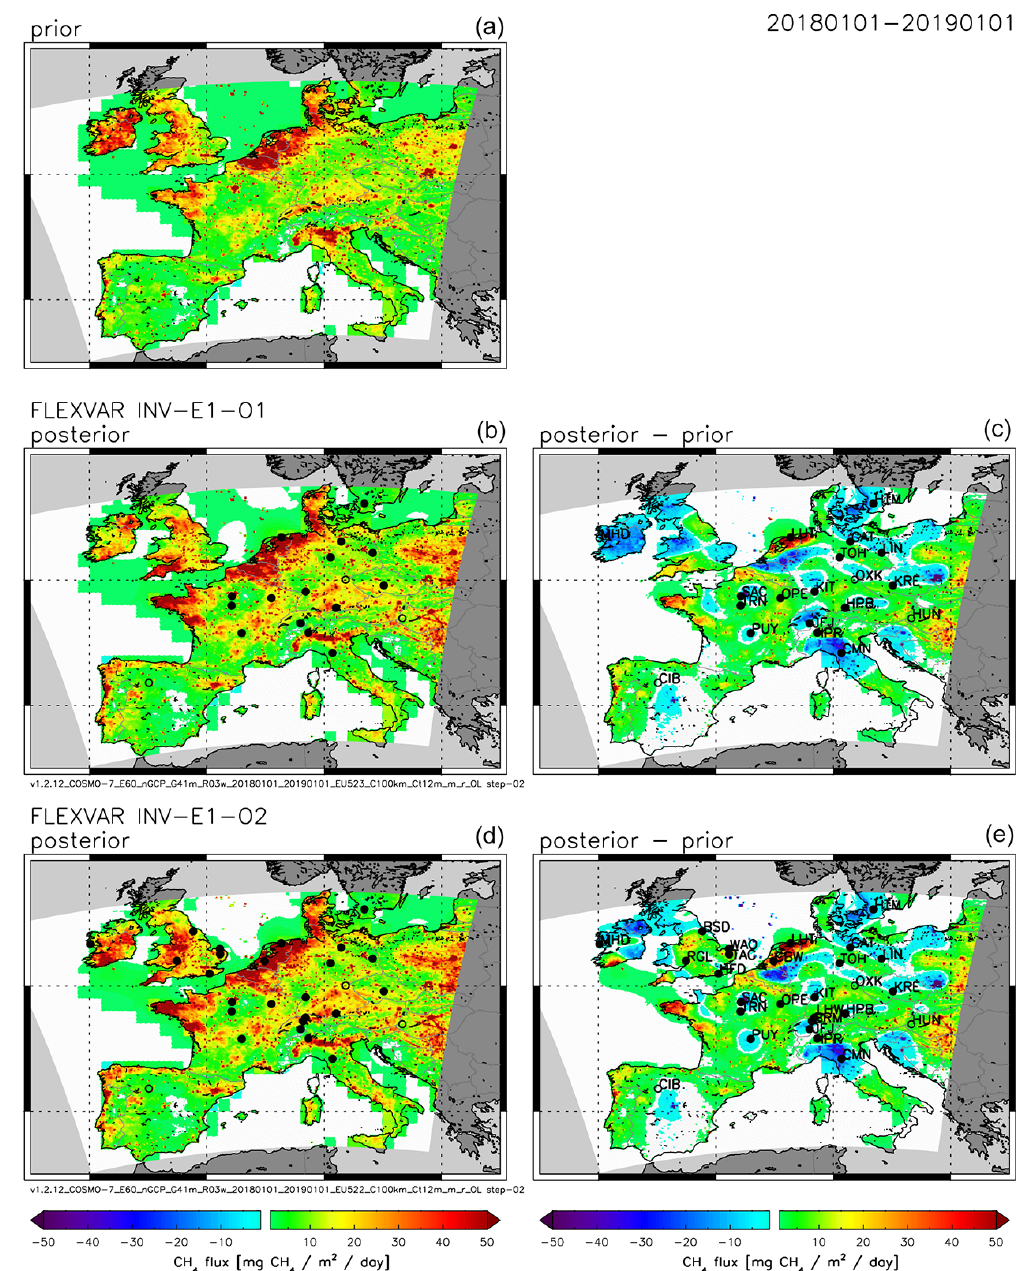
Figure 5. Sensitivity of FLEXVAR inversions to assimilated observations. (a) Prior emission. (b, c) Posterior emissions (left) and difference between posterior and prior emissions (right) for inversion INV-E1-O1 (using observation data set O1). (d, e) Inversion INV-E1-O2 (using observation data set O2). Solid black circles show locations of stations with in situ data and open circles locations of stations with discrete air sampling. All figures show annual average CH 4 emissions (or change in emissions, respectively) for